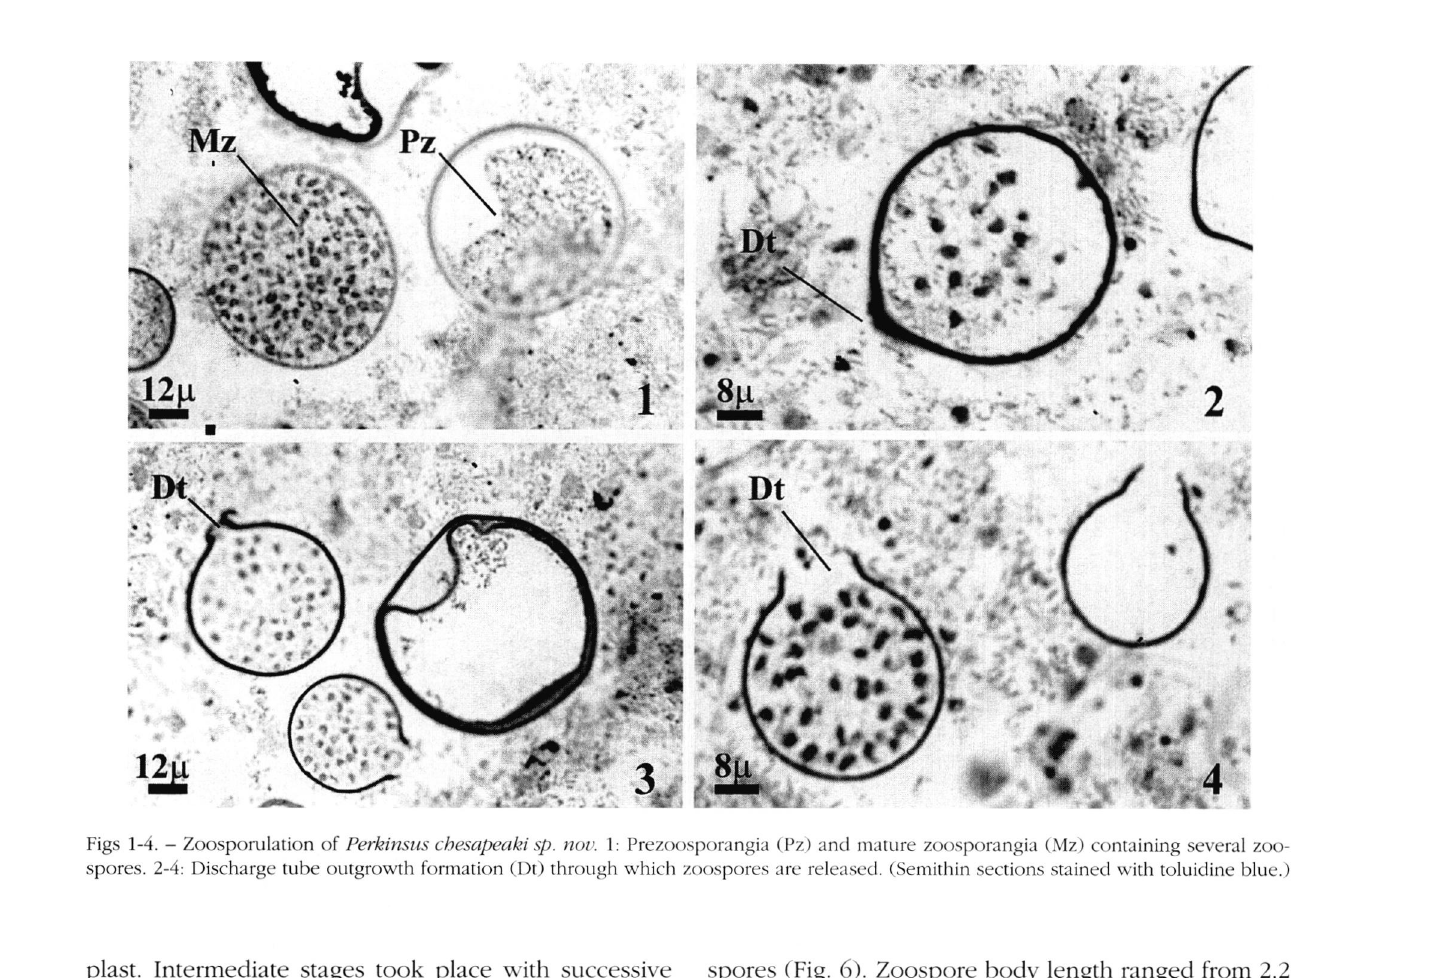
plast. Intermediate stages took place with successive bipartitions of the protoplast. Cells within prezoospo­ rangia changed from spheroidal to smaller rod-like biflagellated zoospores with prominent anterior